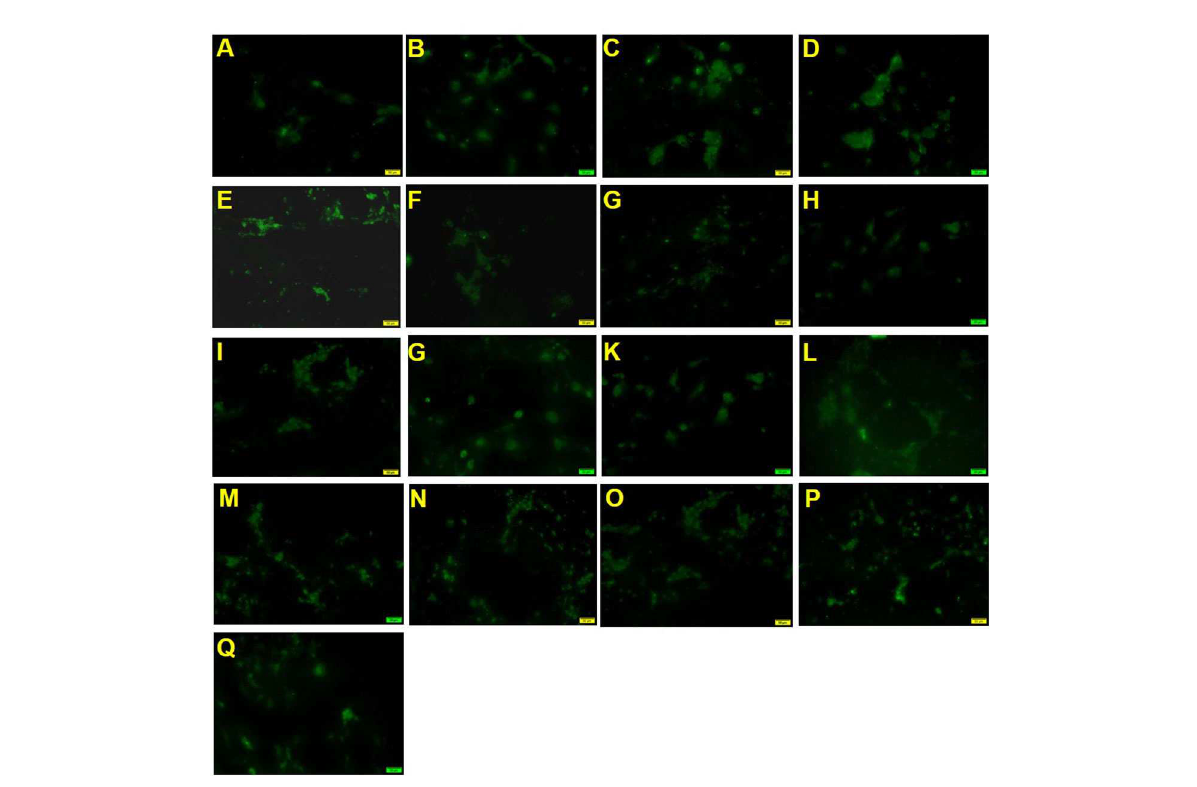
FIGURE2 MAG immunostaining of neural primary cells after treatment with 2 ′ -FL and OPN and DHA for 18 days. (A) , control group; (B) , positive drug; (C) , 2 ′ -FL(H); (D) , OPN(H); (E) , DHA(H); (F) , 2 ′ -FL(L) + OPN(L); (G) , 2 ′ -FL(L) + OPN(H); (H) , 2’-FL(M) + OPN(M); (I) , 2 ′ -FL(H) + OPN(L); (J) , 2 ′ -FL(H) + OPN(H); (K) , 2 ′ -FL(LM) + OPN(LM); (L) , 2 ′ -FL(MH) + OPN(MH); (M) , 2 ′ -FL(L) + OPN(L) + DHA(L); (N) , 2 ′ -FL(L) + OPN(M) + DHA(M); (O) , 2 ′ -FL(H) + OPN(H) + DHA(H); (P) , 2 ′ -FL(LM) + OPN(LM) + DHA(LM); (Q) , 2 ′ -FL(MH) + OPN(MH) + DHA(MH). Scale bar: 50 µ